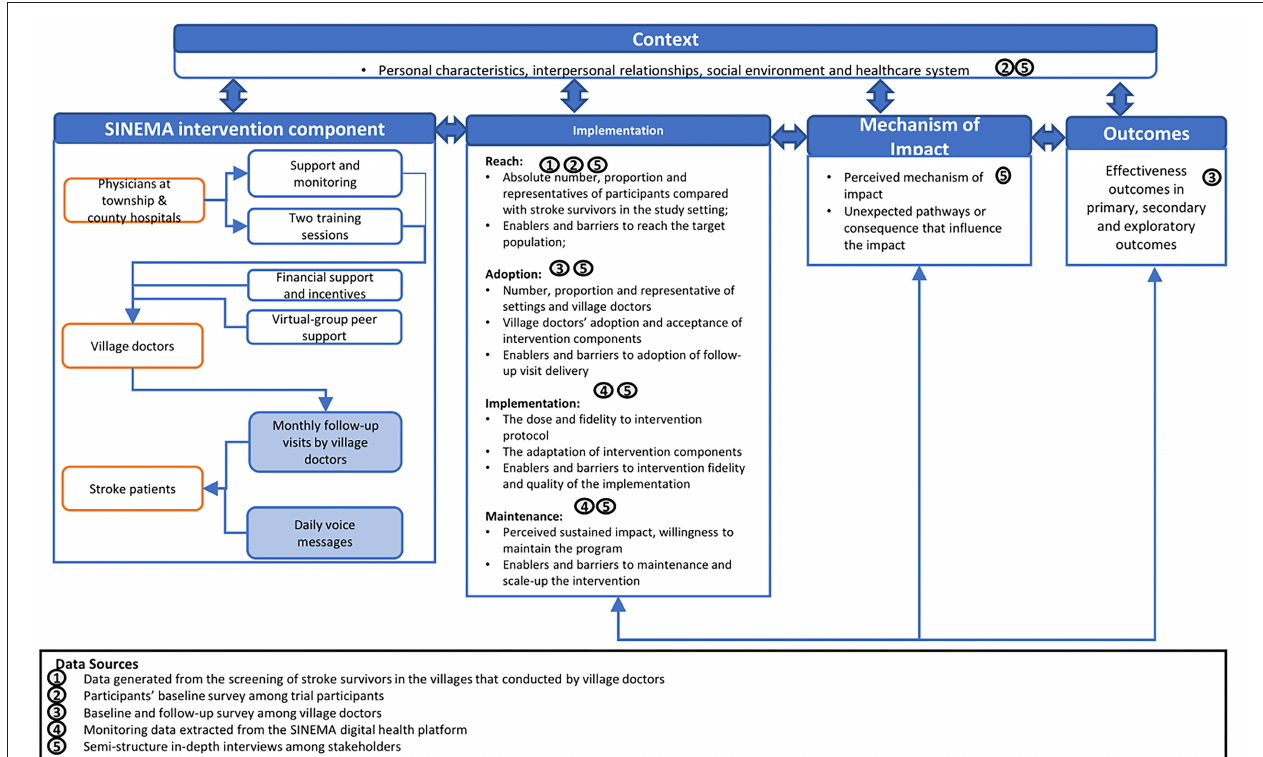
FIGURE 1 | Evaluation